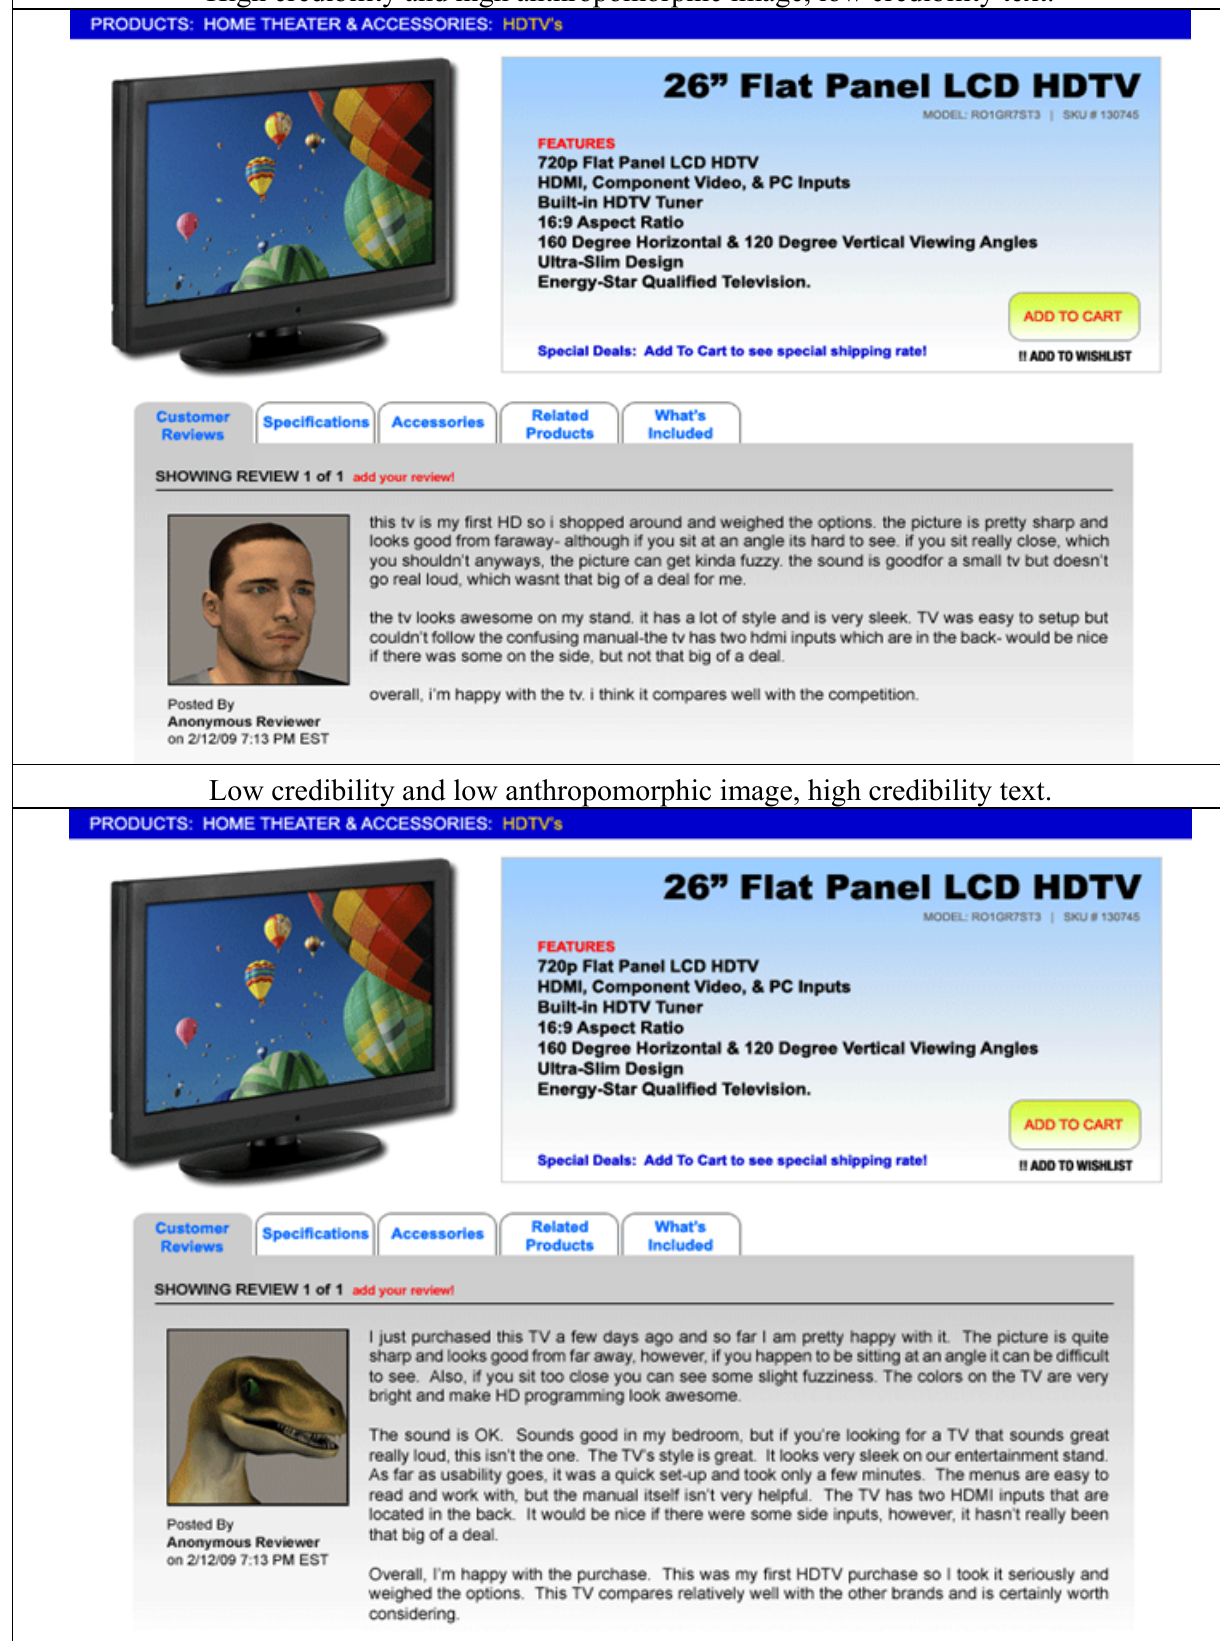
Figure 2. Screen shots of images and text conditions. High credibility and high anthropomorphic image, low credibility text.